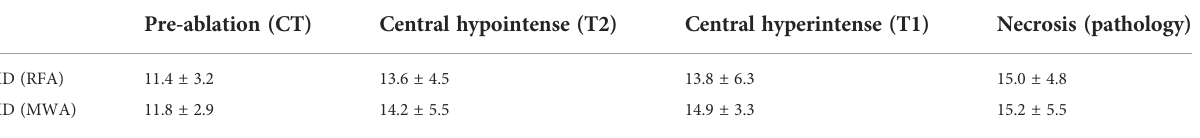
TABLE 2 Comparison of MD of tumor on CT pre-ablation, central hypointense zone on T2WI, central hyperintense zone on T1WI, and MD of coagulative necrosis on pathology post-ablation (mm). Pre-ablation (CT) Central hypointense (T2) Central hyperintense